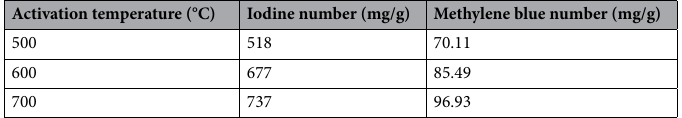
Table 4. Iodine number and methylene blue index of steamed activated carbon